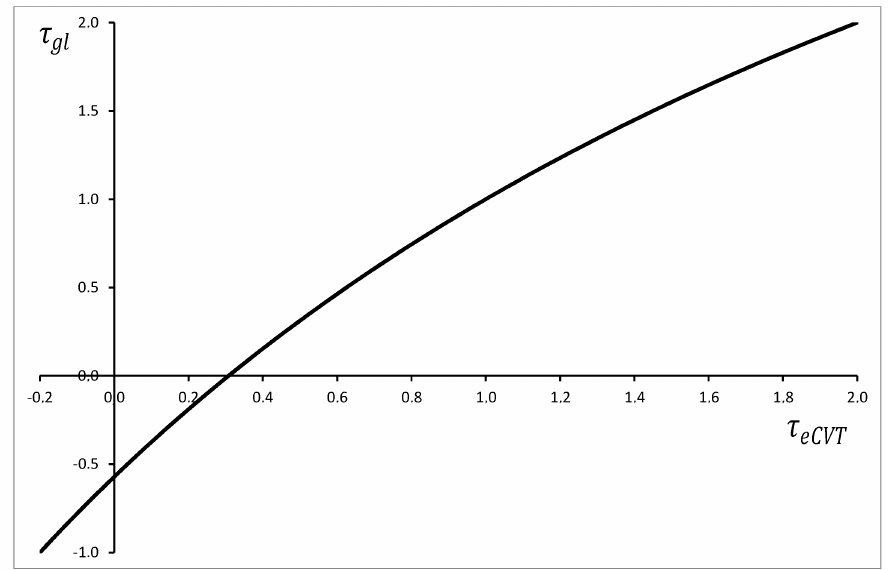
Figure 4. Global transmission ratio as a function of eCVT transmission ratio.